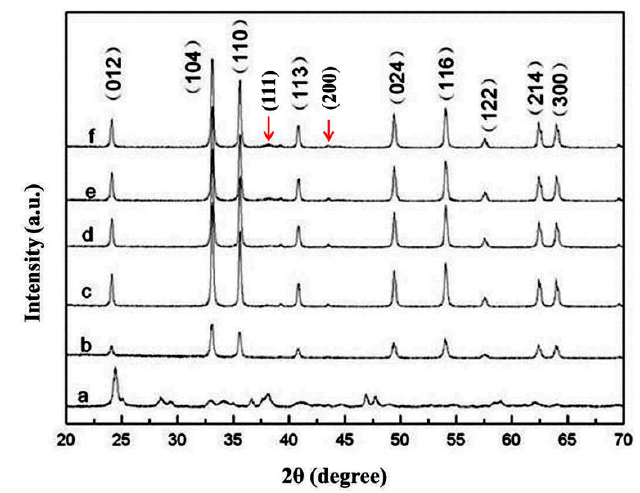
Figure 1. X-ray diffraction (XRD) patterns of (a) precursor, (b) α-Fe 2 O 3 and various amount of Au/α-Fe 2 O 3 catalysts ((c) 0.62%, (d) 1.86%, (e) 2.72%, (f) 3.59%) calcined at 300 °C for 2 h.